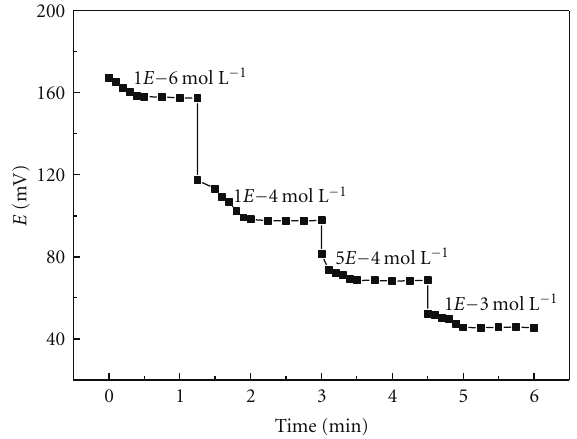
Figure 2: Response time of anionicsurfactant selective electrode for step changes in di ff erent concentration of SDS solution.